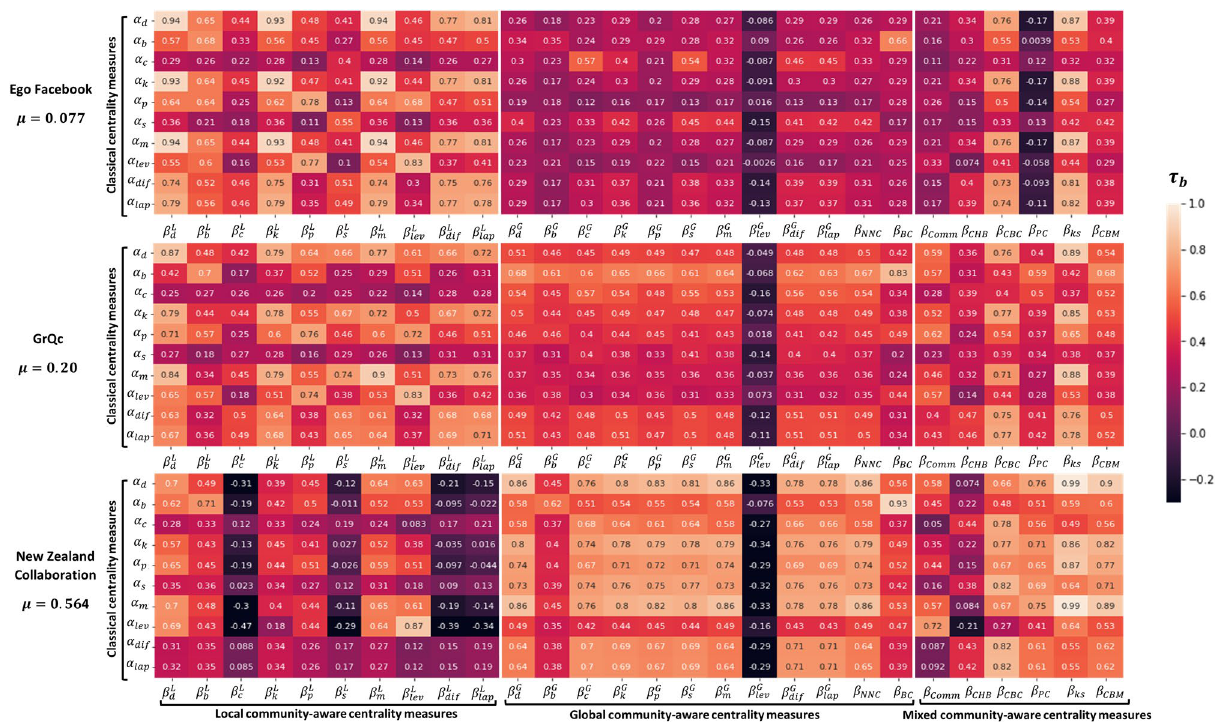
Figure 6. Heatmaps of Kendall’s Tau correlation of the various combinations between classical ( α i ) and community-aware ( β j ) centrality measures in 3 real-world networks. Networks are sorted in ascending order according to their mixing parameter ( µ ). The mixing parameter is deduced after the community structure is uncovered using Infomap community detection algorithm. The classical centrality measures are: α d = Degree, α b = Betweenness, α c = Closeness, α k = Katz, α p = PageRank, α s = Subgraph, α m = Maximum Neighborhood Component, α lev = Leverage, α dif = Diffusion, α lap = Laplacian. The local community-aware centrality measures are: ( β L d , β L b , β L c , β L k , β L p , β L s , β L m , β L lev , β L dif , β L lap ) = the local component of the classical centrality measures based on modular centrality. The global community-aware centrality measures are: ( β G d , β G b , β G c , β G k , β G p , β G s , β G β G β G β G m , lev , dif , lap ) = the global component of the classical centrality measures based on modular centrality, β NNC = Number of Neighboring Communities centrality, β BC = Bridging centrality. The mixed community- aware centrality measures are: β Comm = Comm centrality, β CHB = Community Hub-Bridge centrality, β CBC = Community-based centrality, β PC = Participation Coefficient, β ks = K-shell with Community centrality, β CBM = Community-based Mediator